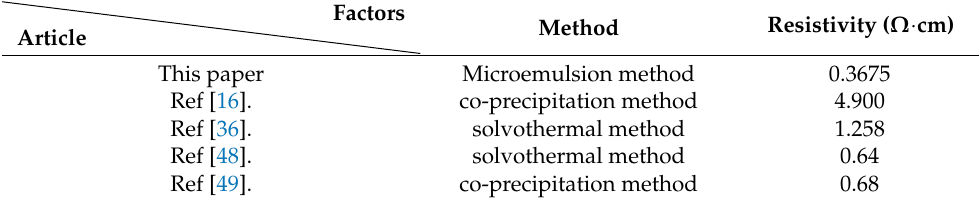
Table 6. Resistivity comparison of ITO